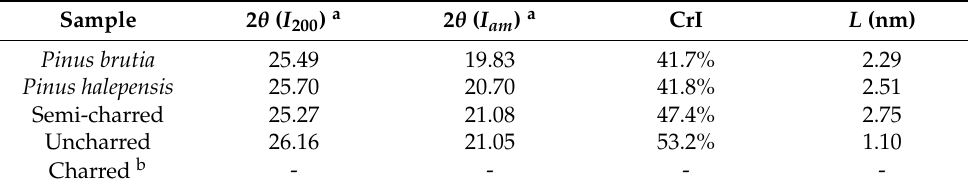
Table 1. Band positions of the maximum total intensity ( I 200 ) and the minimum intensity of the amorphous cellulose ( I am ). CrI represents the crystalline index based on Segal’s method and L correspond to the crystallite